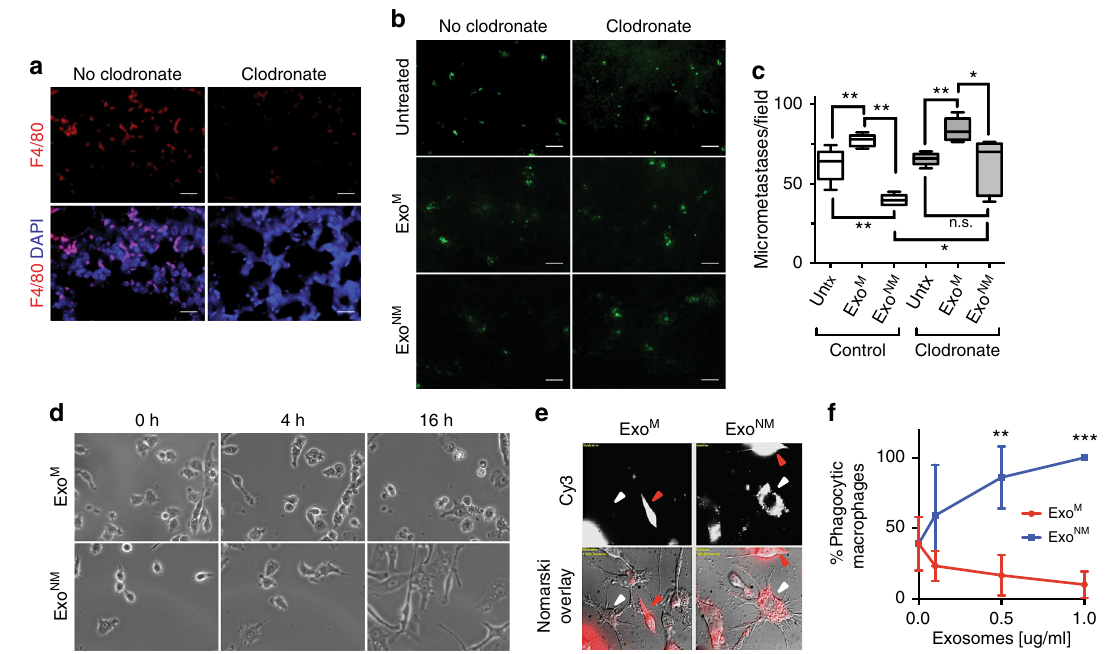
Fig. 3 Exo NM act via the cells of monocytic lineage. a – c Mice were treated with control or clodronate liposomes to eliminate monocytes/macrophages, then pre-conditioned with exosomes (10 μ g per mouse) and used in the extravasation assay as described above. a Macrophage depletion was assessed by F4/80 IF ( n = 3, scale bar, 100 μ m) or CD11b IF (Supplementary Fig. 5). b , c The inhibition of B16F10 extravasation by Exo NM was diminished by monocyte depletion. Representative lung images (5× magni fi cation) are shown in b (scale bar, 100 μ m), and quantitative analysis is shown in c ( n = 5 untreated, n = 6 Exo M , Exo NM , fi ve random images analyzed per animal). * P < 0.05 and ** P < 0.01 calculated by two-tailed t -test in pairwise comparison. Median values